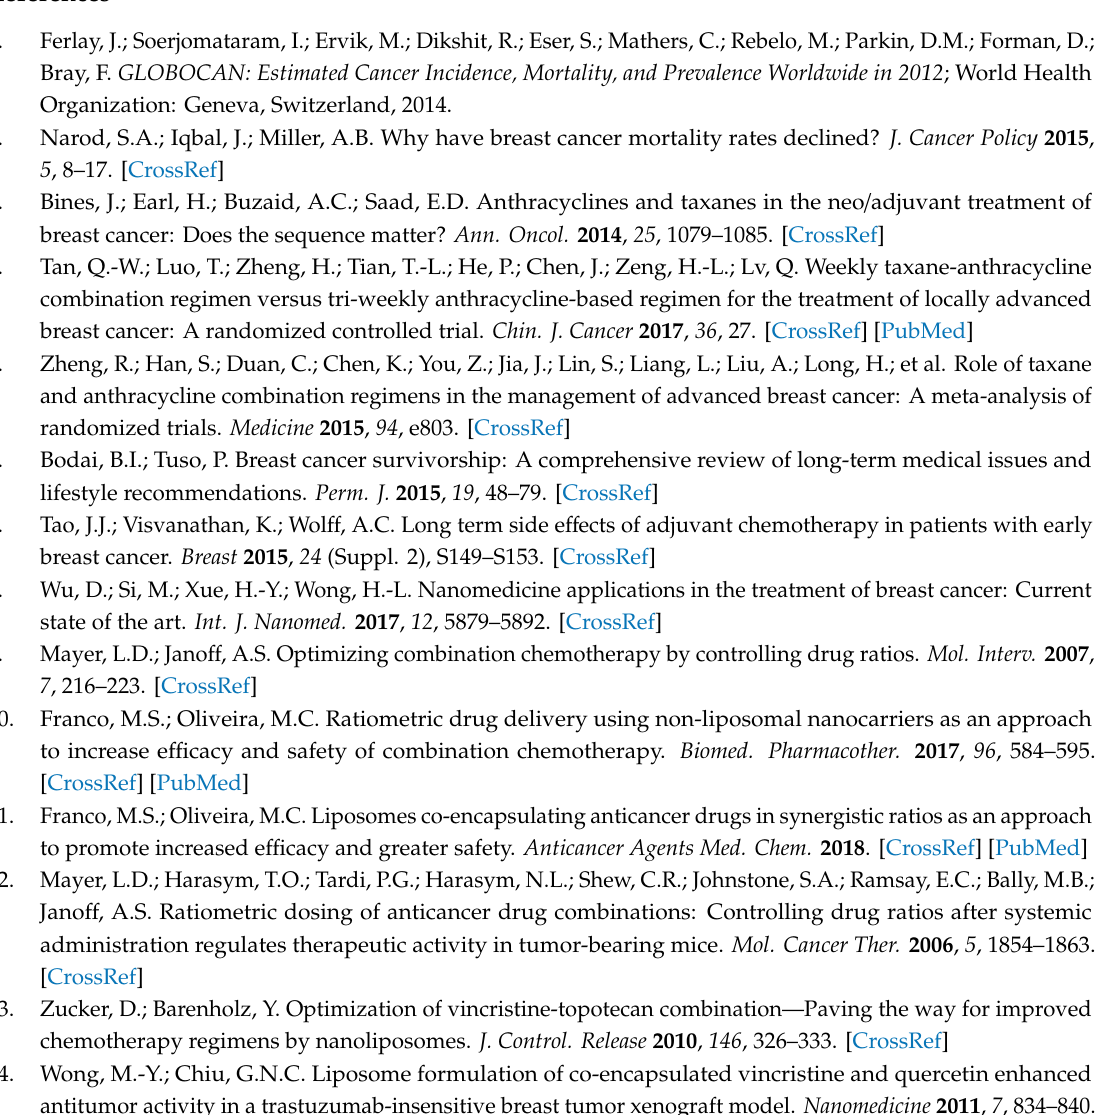
Figure S1: Intensity particle size distribution for LCFL-Blank ( A ), LCFL-PTX ( B ), LCFL-DXR ( C ), LCFL-PTX / DXR 10:1 ( D ), LCFL-PTX / DXR 1:1 ( E ), LCFL-PTX / DXR 1:10 ( F ), Figure S2: Cell viability curves for MDA-MB-231 (panel A ); MCF-7 (panel B ) and SKBR-3 (panel C ) cell lines when exposed to di ff erent ratios of free or liposome co-encapsulated PTX and DXR for 48